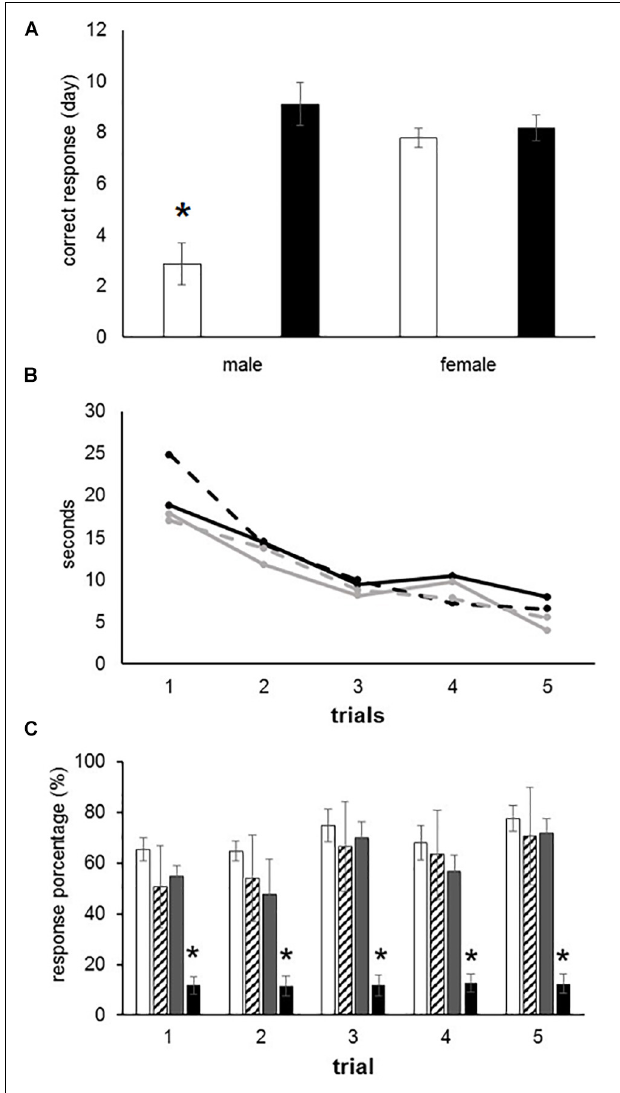
FIGURE 1 | Learning deficits in prenatally ozone exposed rats. (A) T-maze test showing a significant increased latency to reach the correct response in ozone exposed males as compared to control (black bars) using one-way ANOVA comparison statistics. (B) Progressive improvement to find the recompense in the T-maze test without differences between groups. (C) Significant reduction to reach the correct response in female rats exposed to ozone using the Skinner box. The bars indicate the means ± SEM, using the repeated measures ANOVA. ∗ P ≤